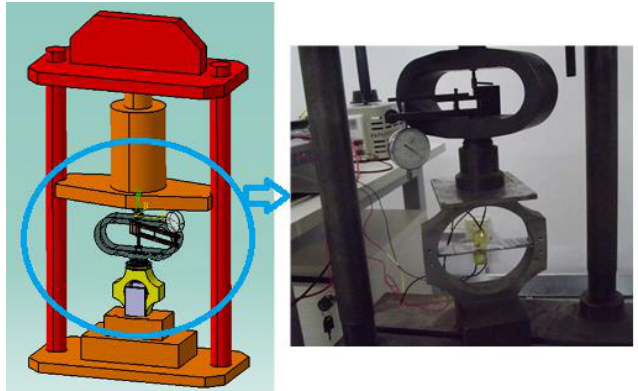
Figure 6. Tension test calibration device and the installation of contralateral sensor with